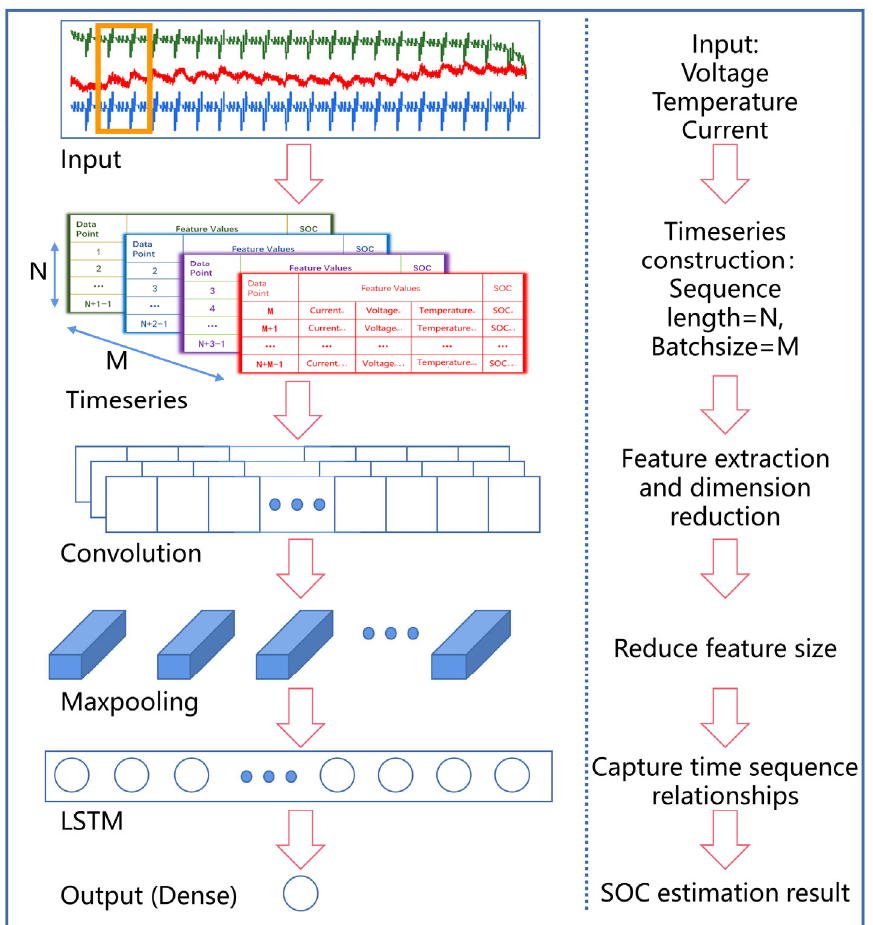
Figure 2. The architecture of the CNN ‐